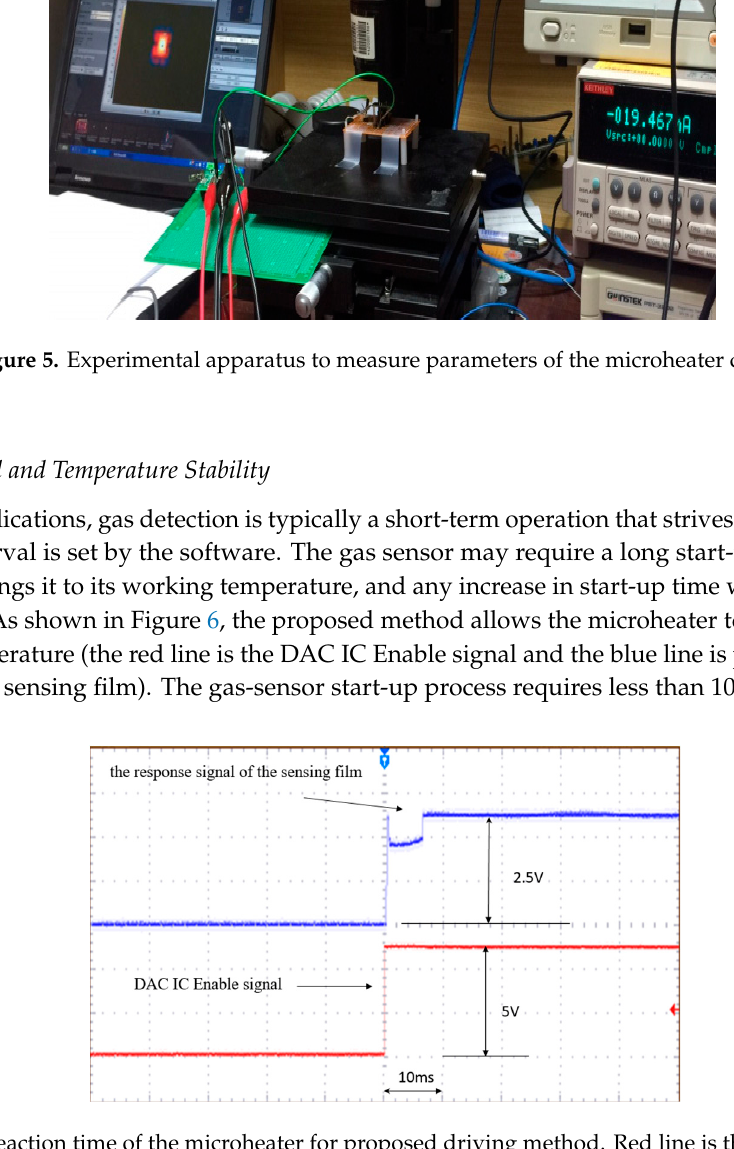
Figure 5. Experimental apparatus to measure parameters of the microheater circuit.